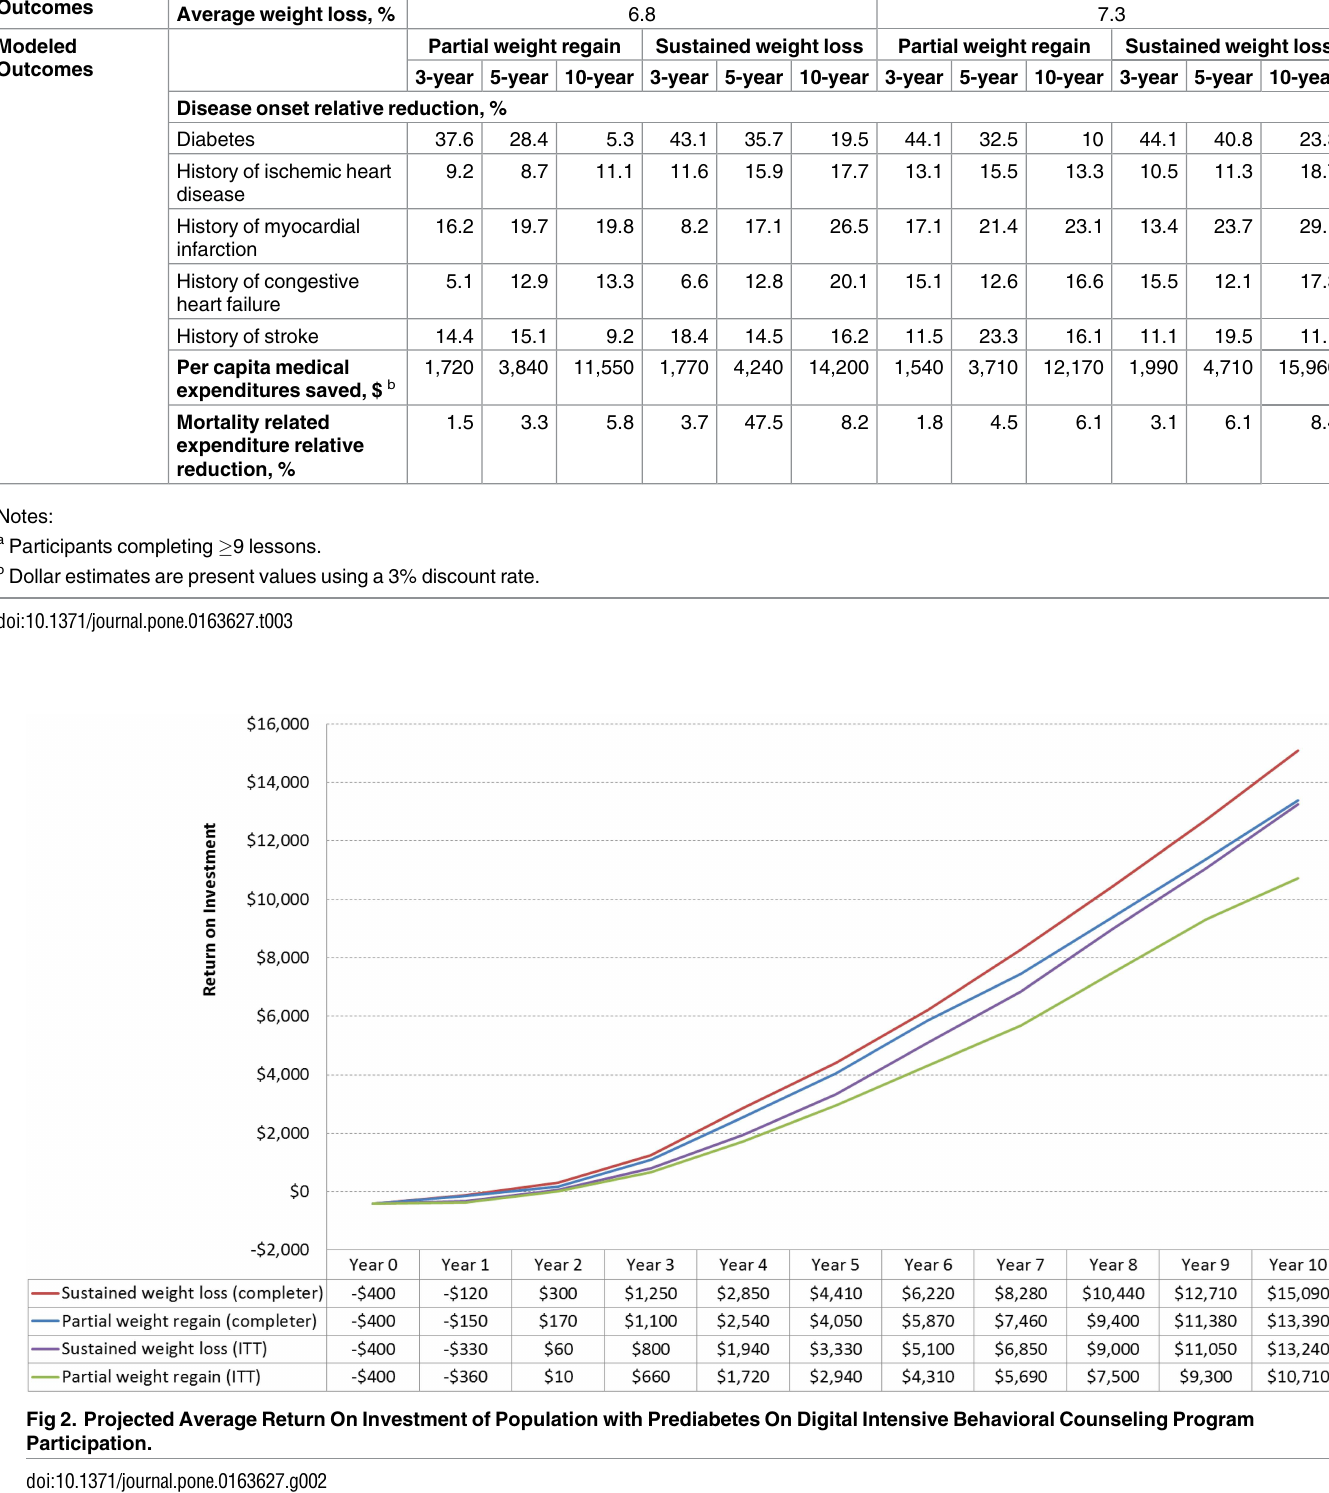
Intent-To-Treat